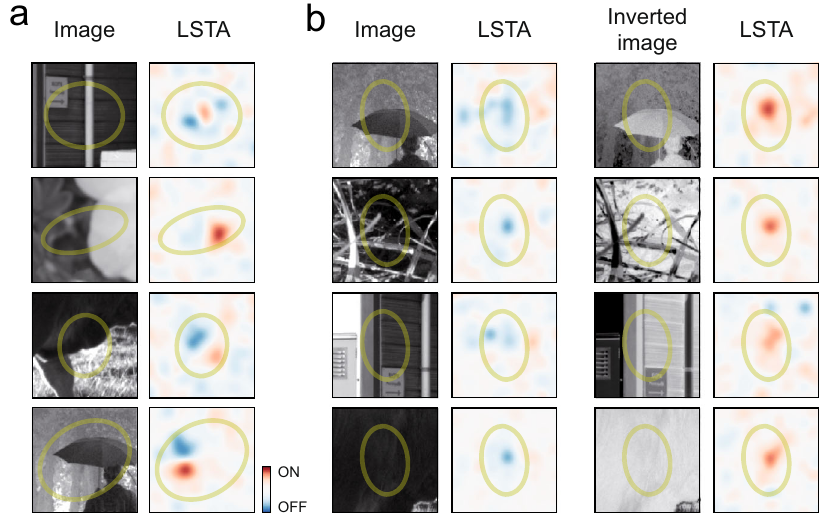
Fig. 5 | Contrast computation is con fi rmed using natural images and their inverted bright-dark counterparts. a Four example images presenting high contrast in the center of the receptive fi eld of four mouse ganglion cells. As hypothesized (see text), bright (dark) regions in the image correspond to bright (dark) LSTA regions. b An example of OFF ganglion cell of mouse